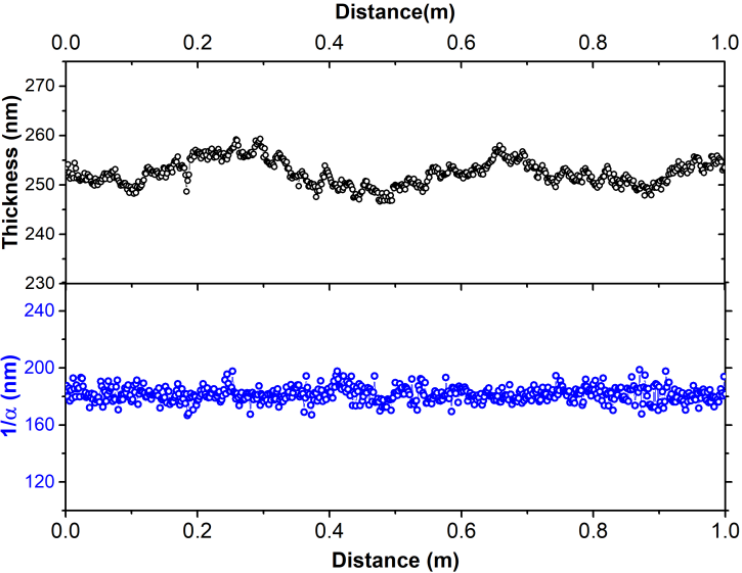
Figure 2. Calculated thickness ( top ) and penetration depth 1/ α ( bottom ) of the photoactive layer at photon energy of 2.37 eV (wavelength of 532 nm) across the 1 m width web.